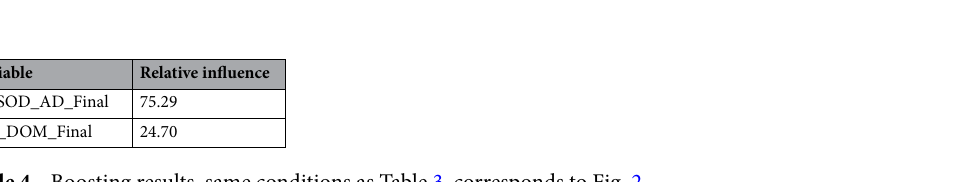
Table 4. Boosting results, same conditions as Table 3, corresponds to Fig.